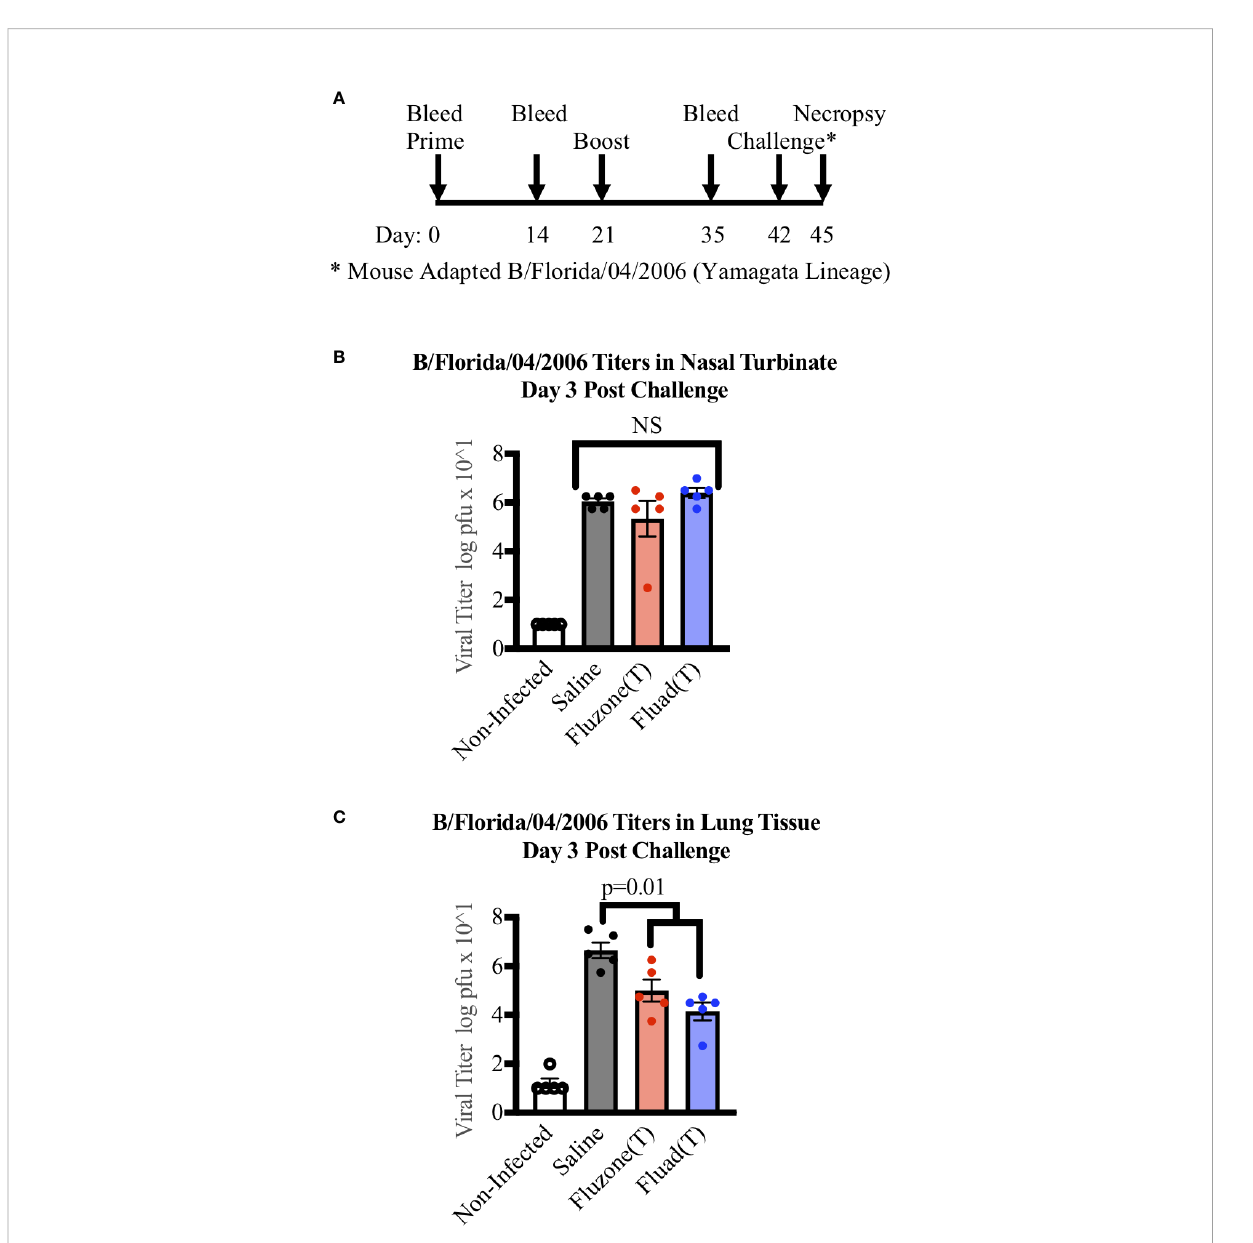
FIGURE 4 Measuring viral titers in the nasal turbinates and lungs of mice following quadrivalent and trivalent vaccinations and subsequent challenge with Yamagata-lineage in fl uenza B virus. (A) Immunization and challenge schedule with prime and boost (day 0 and 21), intranasal challenge (day 42), and bleeds (day 0, 14, and 35). On day 45 mice were euthanized for the harvesting of lungs and nasal turbinates. (B) Viral levels in the nasal turbinates of mice as measured by tissue culture infectious dose 50 (TCID50). (C) Viral levels in the left lung of mice as measured by TCID50. P- values are indicated for the signi fi cance of differences and NS denotes no statistical difference. Vaccines were Flucelvax (Q) (green), Fluad (T) (blue) and Fluzone (T) (red) with saline (black) and non-infected controls (white). Yamagata-lineage challenge virus was mouse-adapted B/